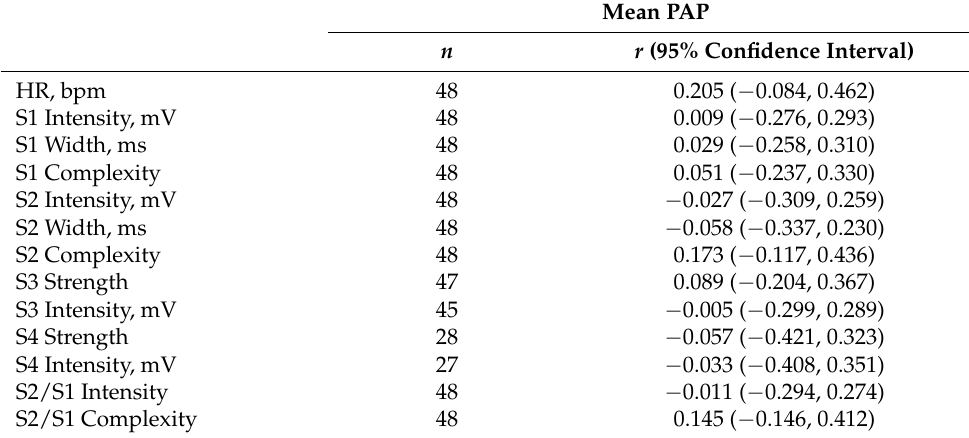
Table 4. Correlation between changes from baseline to post-exercise in PAP and